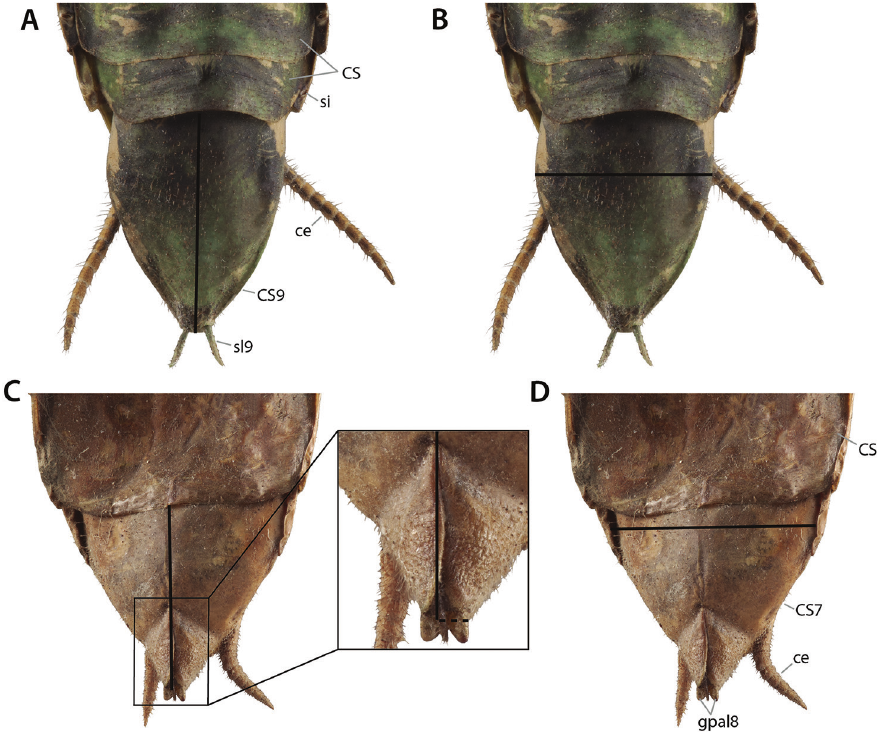
Figure 29. Coxosternite 7/9 (= ♀ / ♂ subgenital plate) length and width measurement standard. Solid black lines indicate approximate location to take length and width measurements. Dashed black lines dem- onstrate approximate locations for measurement endpoints. Omomantis sp. ♂ CS9 , ventral view ( A – B ): A length B width. Sphodromantis sp. ♀ CS7 , ventral view ( C – D ) C length with inset showing approximate location for length measurement endpoint D width. Abbreviations: ce = cercus; gpal8 = apical lobe of gona- pophysis 8; CS = coxosternite; CS7 = ♀ coxosternite 7; CS9 = ♂ coxosternite 9; si = spiracle; sl9 =